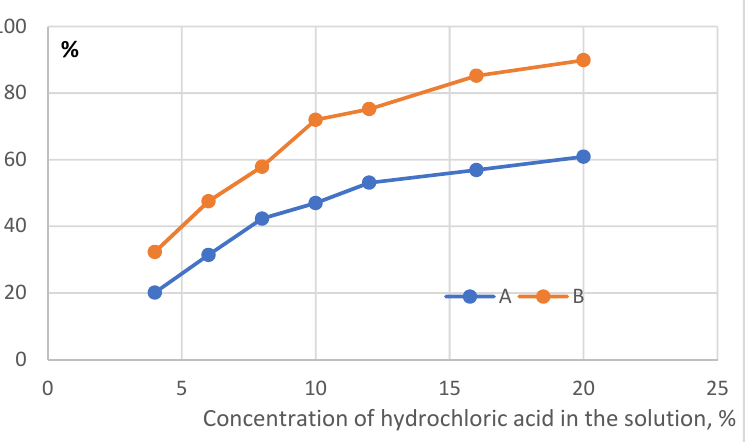
Figure 6. Average Copper extraction (%) without mechanical activation (A) and with mechanical activation (B).